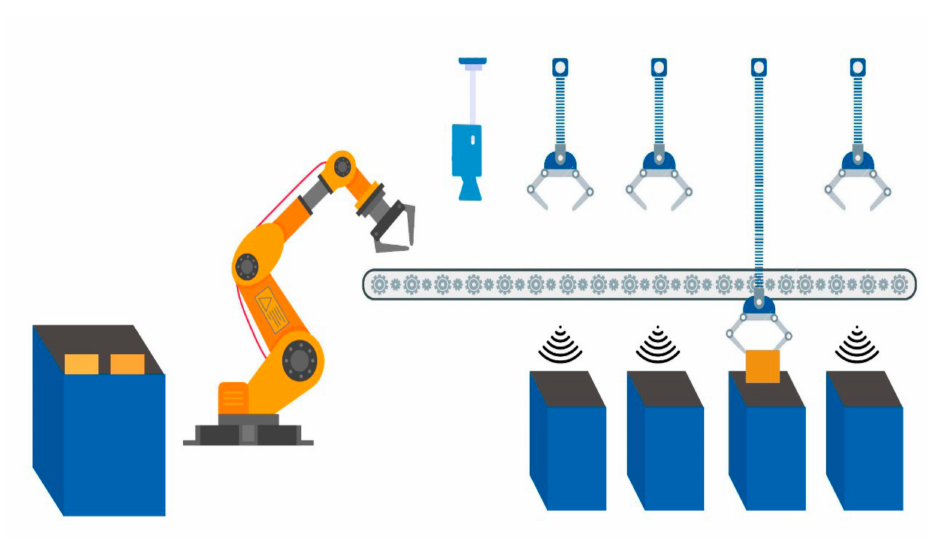
Figure 2. Taking a picture of waste item and classifying.